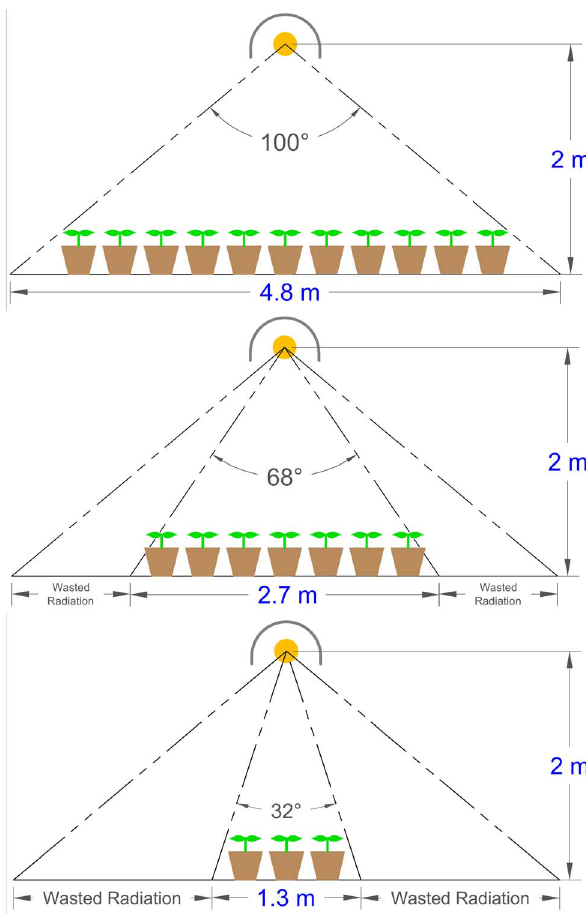
Figure 2. Canopy photon capture efficiency. As the plant growth area under the fixture gets smaller, wasted radiation often increases. This figure illustrates the concept of canopy photon capture efficiency. Two meters was chosen as a typical mounting height, but this can be scaled as a unit-less ratio. Multiple overlapping fixtures are typically used to minimize PPF variation over a large area.